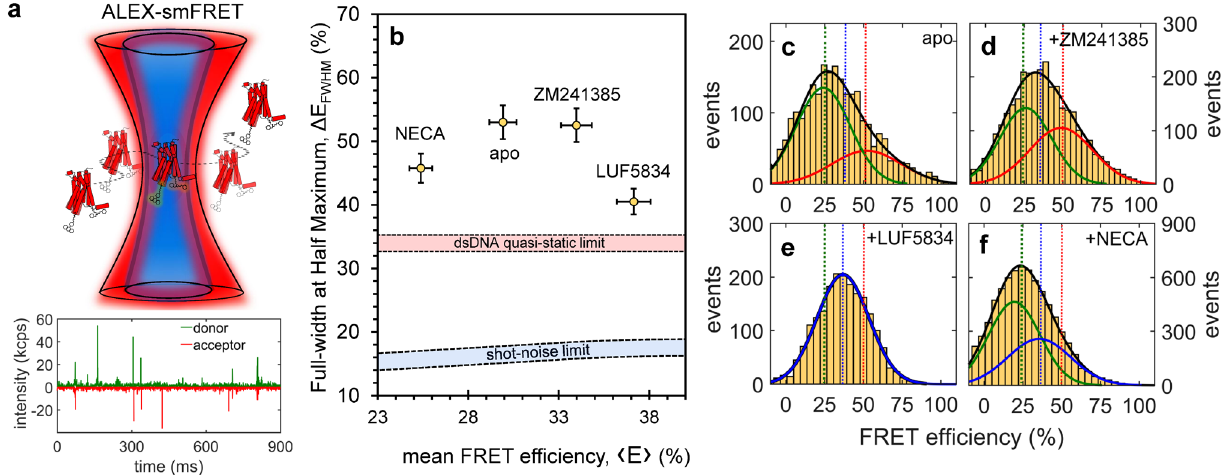
Figure 1. Ligand-induced changes in A 2A R conformations measured by smFRET. ( a ) A double-cysteine mutant of A 2A R (T119C Q226C) labelled with AF488 (donor) and AF647 (acceptor) was alternately excited with blue (473 nm) and red (635 nm) lasers; bursts of fluorescence of the donor (green) and the acceptor (red) were recorded from single receptors diffusing through the confocal detection volume. The FRET efficiency E for each burst was calculated using Eq. 1a and the values obtained from all bursts for each ligand condition were used to build smFRET histograms ( c – f ). ( b ) Width (ΔE FWHM ) vs. mean (< E >) for the FRET efficiency distributions shown in ( c – f ); the error bars were estimated by statistical bootstrapping. Shown as reference are the regions of the shot-noise limit (blue) and of the quasi-static limit (dsDNA, pink) (see SI Sect. 1.2 for details). ( c – f ) smFRET distributions of A 2A R in the ( c ) basal state (apo), and in the presence of ( d ) 100 μM ZM241385 (antagonist), ( e ) 100 μM LUF5834 (partial agonist), and ( f ) 100 μM NECA (full agonist), fitted to a sum of Gaussians (black line). Solid blue, green and red lines represent individual Gaussians and corresponding dashed vertical lines represent their peak center. The results of the fitting are shown in Table